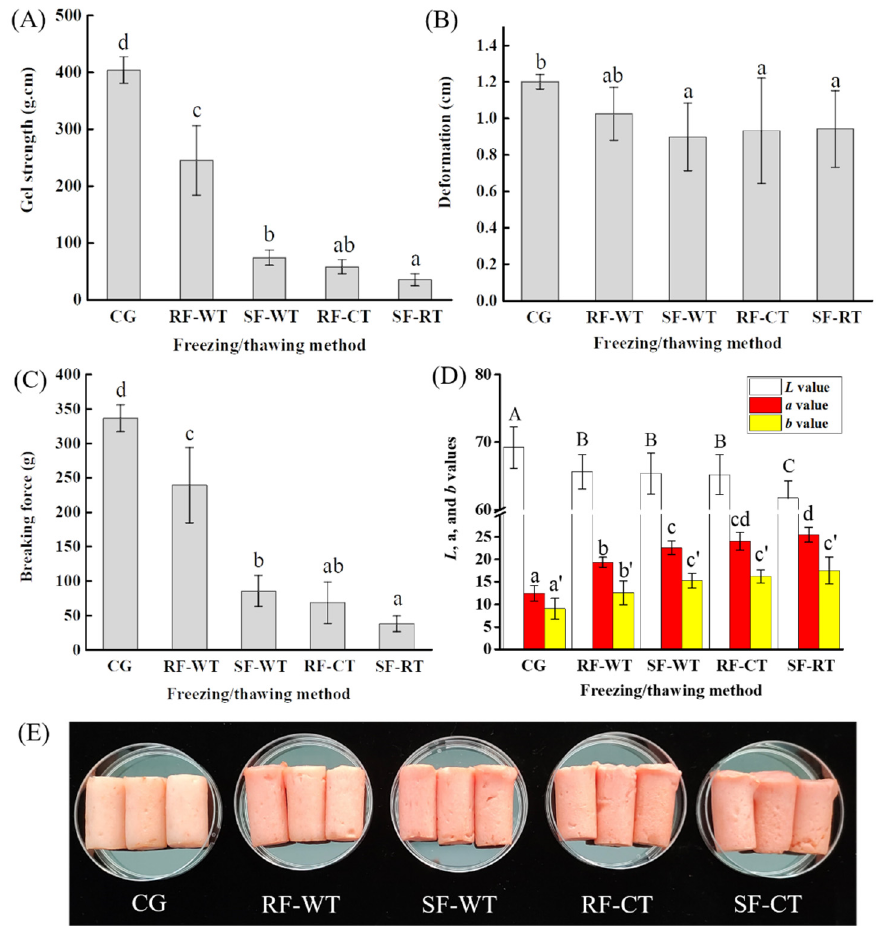
Figure 3. Texture properties ( A – C ), color ( D ), and appearance ( E ) of crayfish meat gels prepared by different freezing-thawing combinations. Different letters (a–d) in ( A ) for gel strength, letters (a–b) in ( B ) for deformation, letters (a–d) in ( C ) for breaking force, and letters (( A – C ) for L value; (a–c) for a value; a’–b’ for b value) in ( D ) indicate significant differences ( p < 0.05). CG, control group; RF, rapid freezing; SF, slow freezing; CT, cold thawing; WT, water immersing thawing.